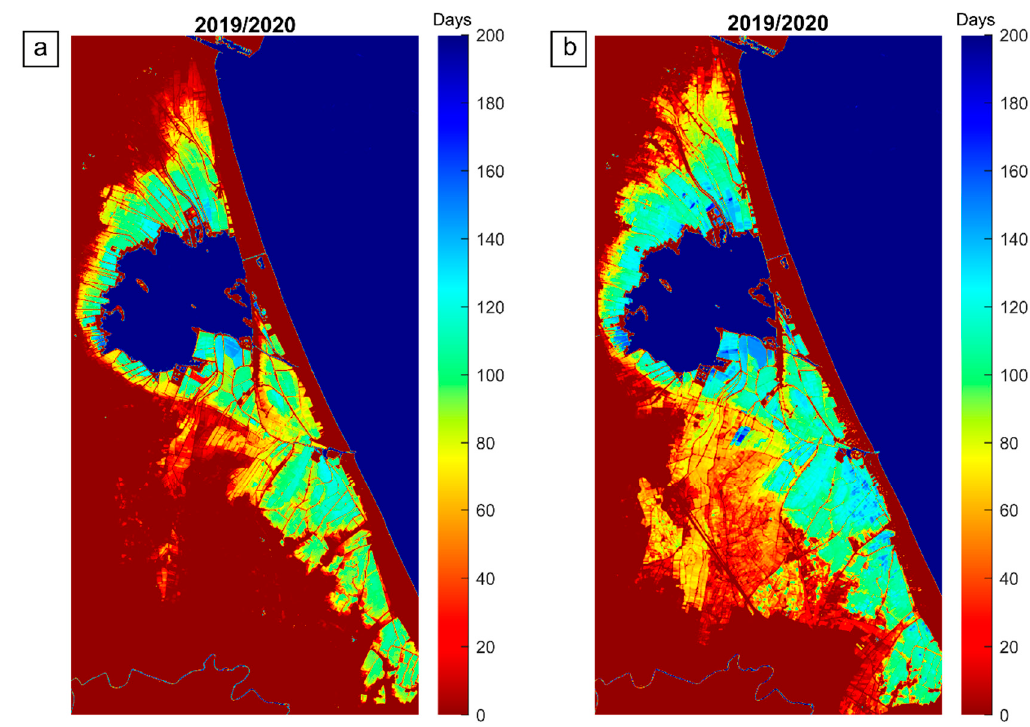
Figure 12. Days of water presence from October to April in 2019/20; ( a ) W class; ( b ) W class plus M class.